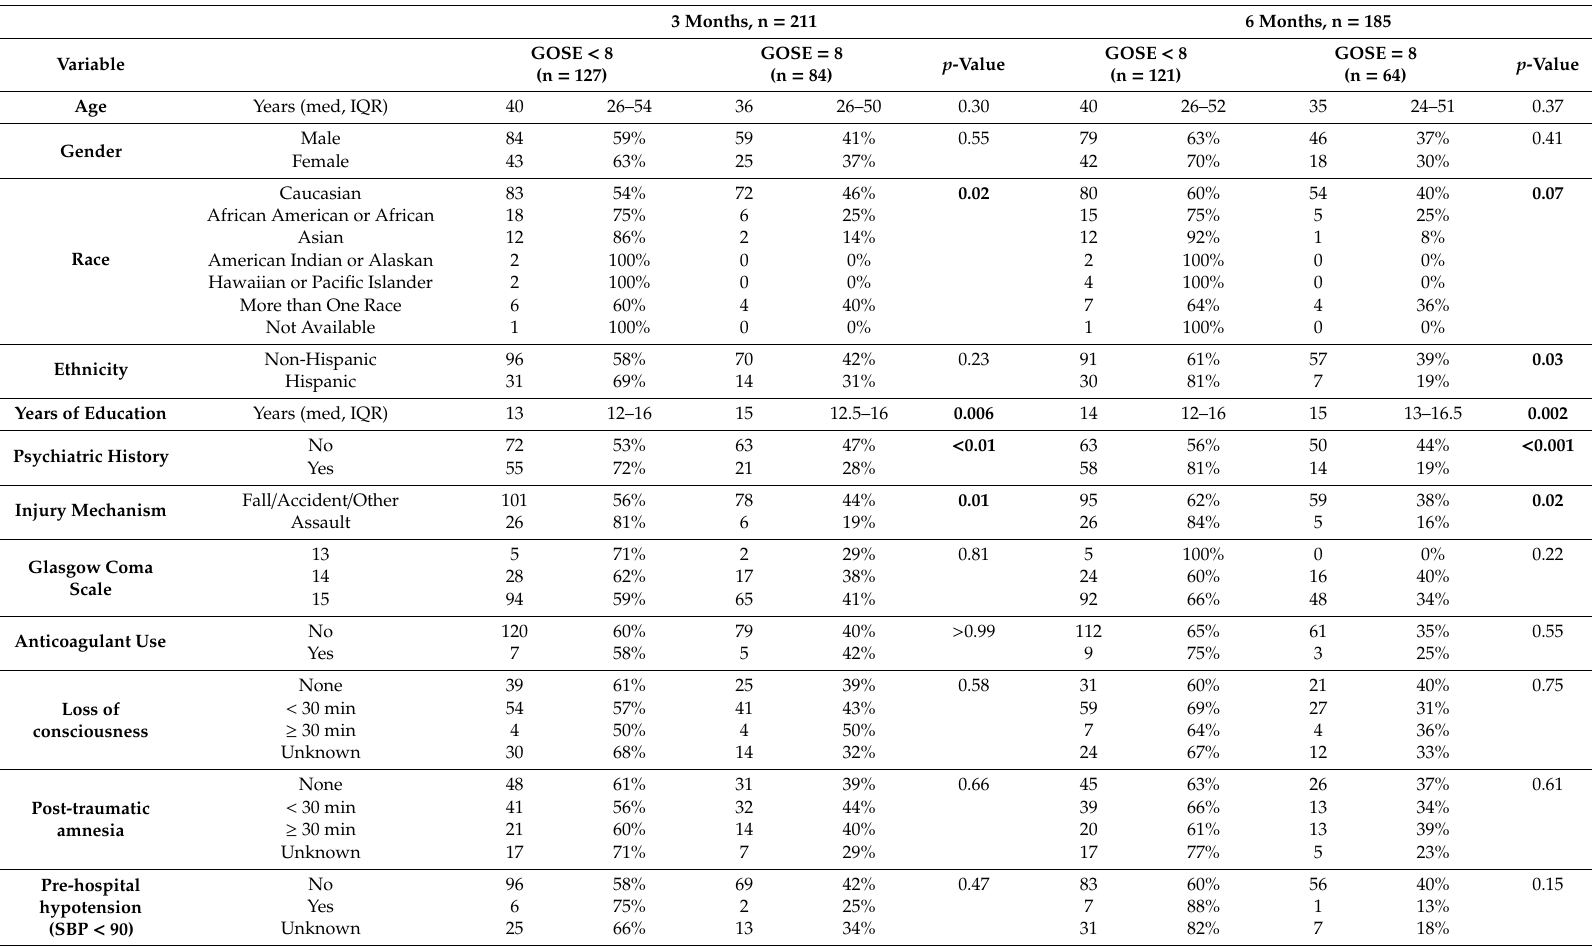
Table 1. Univariate associations between demographic and clinical characteristics and functional deficits at 3 and 6